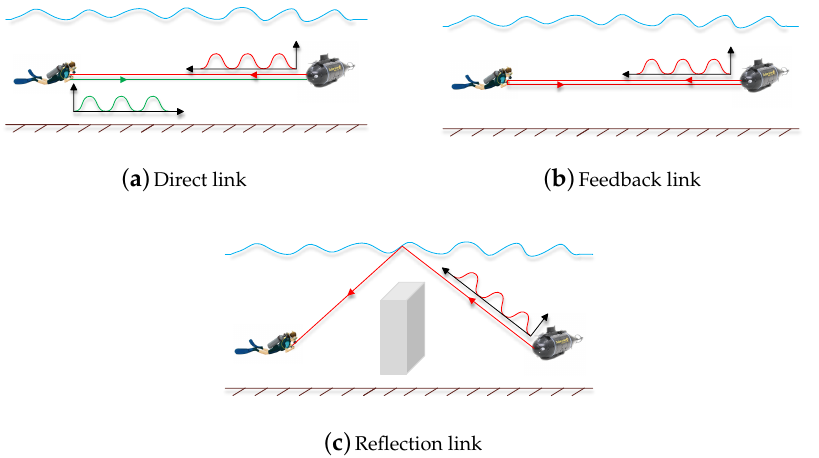
Figure 3. Three link models of end-to-end underwater CV-QKD